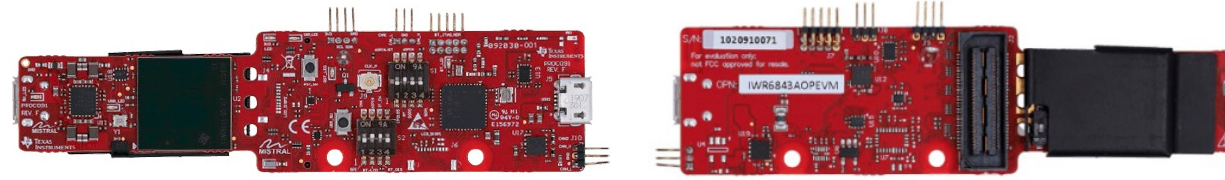
Figure 2. IWR6843AOP appearance diagram. Table 1. The key parameters of the radar.